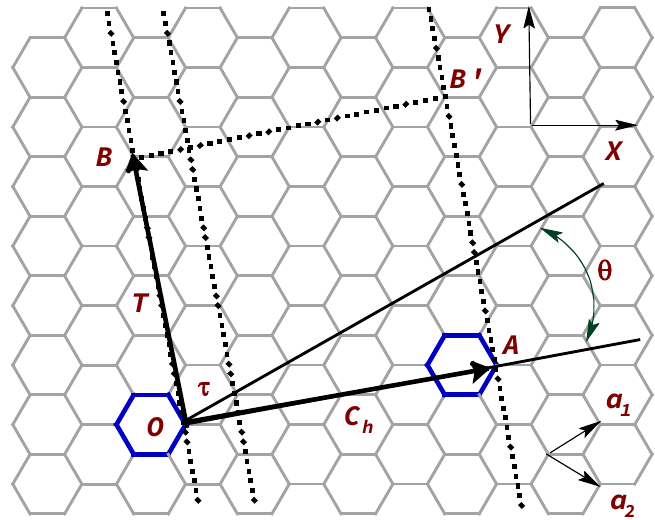
Figure 3. Honeycomb lattice structure of graphene and the main parameters that control the chirality and electronic properties of the resultant nanotube (adapted by permission from References [8,23]).